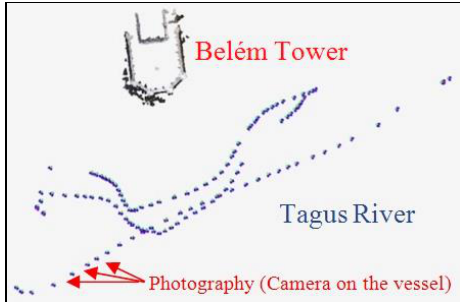
Figure 4. Scheme of camera positions on the vessel relative to the tower. Blue points indicate camera positions. camera positions.